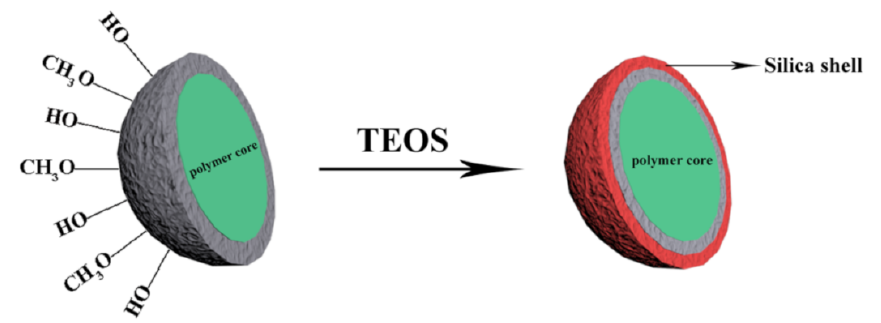
Figure 10. Schematic diagram of the bridging of coupling agent.